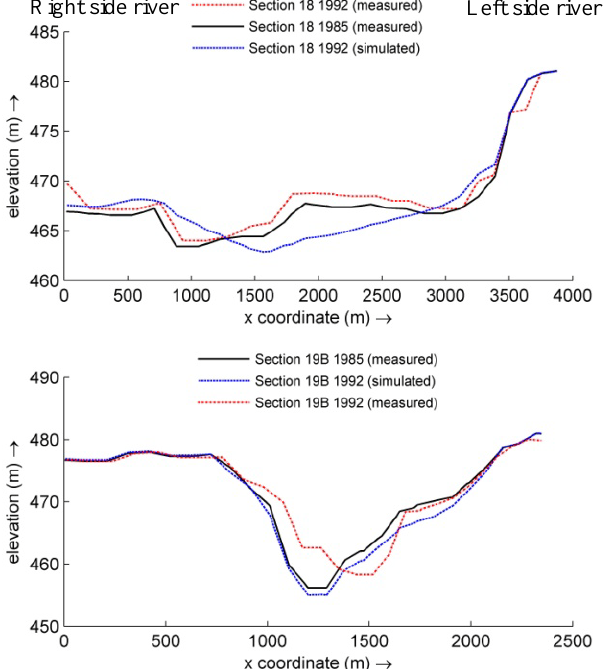
Figure 8. Cross sections 18 and 19B seen from downstream. Mea- sured 1985 and 1992 bed elevations and simulated 1992 bed el- evation. Cross sections 18 and 19B are located 10.8 and 15.4km Fig. 8. Cross-sections 18 and 19B seen from downstream. Measured 1985 and 1992 upstream of the dam, bed elevations and simulated 1992 bed elevation. Cross-section 18 and 19B are located 10.8 km and 15.4 km upstream of the dam, respectively.